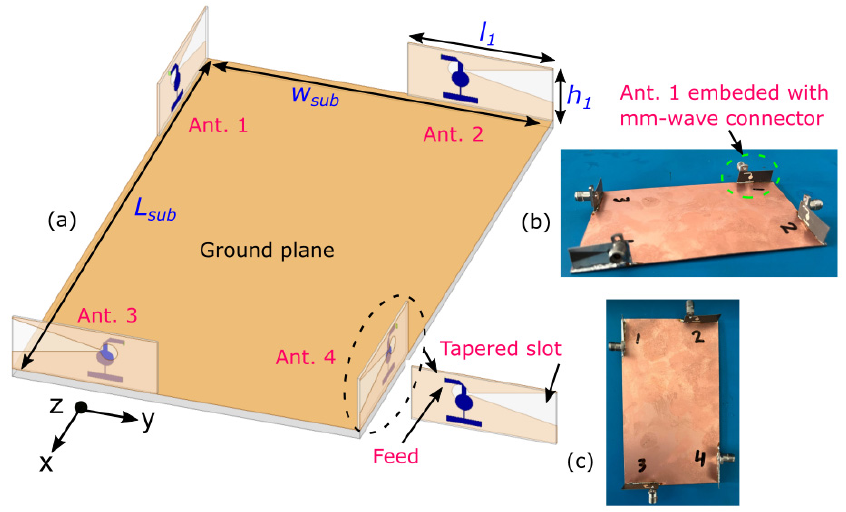
Figure 2. The proposed MIMO antenna design: ( a ) full configuration; ( b , c ) fabricated prototype. To achieve a pattern of diversity at both Sub-6 GHz and mm-wave bands, the tapered slot antenna design is integrated along the four sides of the substrate, establishing an MIMO antenna design. The performance of Ant. 1 is depicted in Figure 3. It can be seen from the S-parameters curves that Ant. 1 operates at 3.6 GHz in the 3.5 to 3.8 GHz band as an open slot antenna, and at 28 GHz in the 25 GHz to 29 GHz band as a Vivaldi antenna. These observations can be verified by the 3D radiation patterns shown in Figure 3. Ant. 1 provides a wide beam width at the 3.6 GHz band with a 4 dBi realized gain, and a narrower beam width with a higher realized gain of 8 dBi at 28 GHz. Since Ant. 1 is based on a tapered slot structure, the direction of the radiation is end-fire, as shown in Figure 3. The operating band resonances can be tuned by changing the width and length of the tapered slot. A detailed design procedure with all dimensions is provided [20].